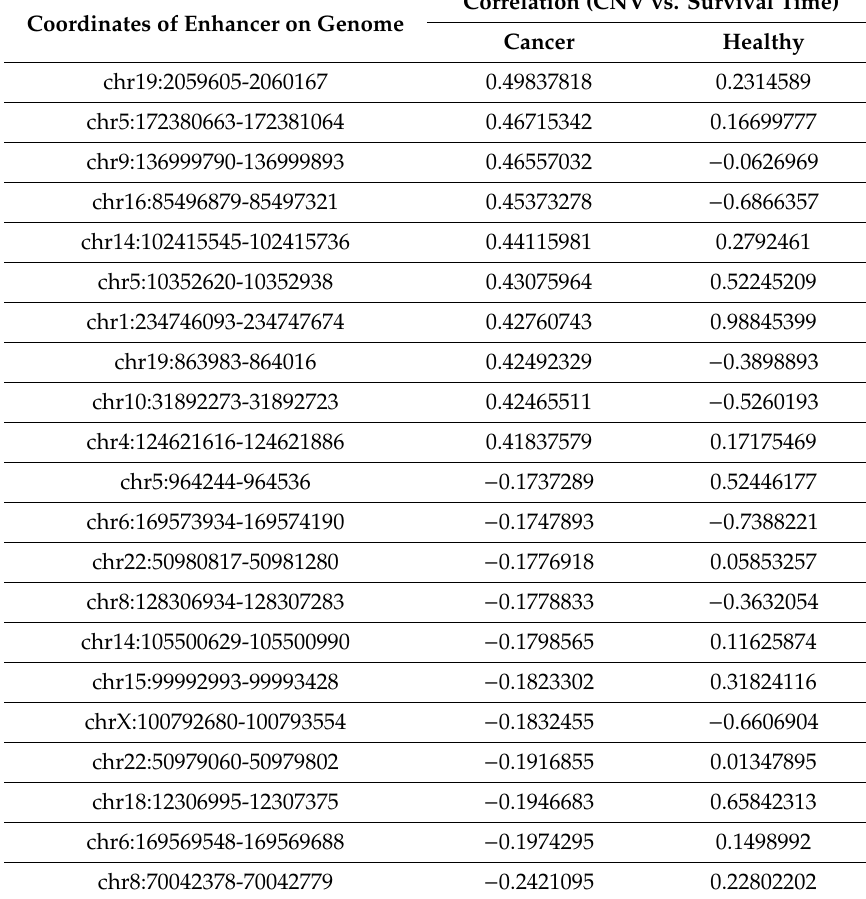
Table 4. Correlation between CNV of enhancers and survival of patients in the case of cancer patients and healthy individuals. The red-to-green color gradient shows high to low correlation. Correlation (CNV vs. Survival Time) Coordinates of Enhancer on Genome Cancer Healthy chr19:2059605-2060167